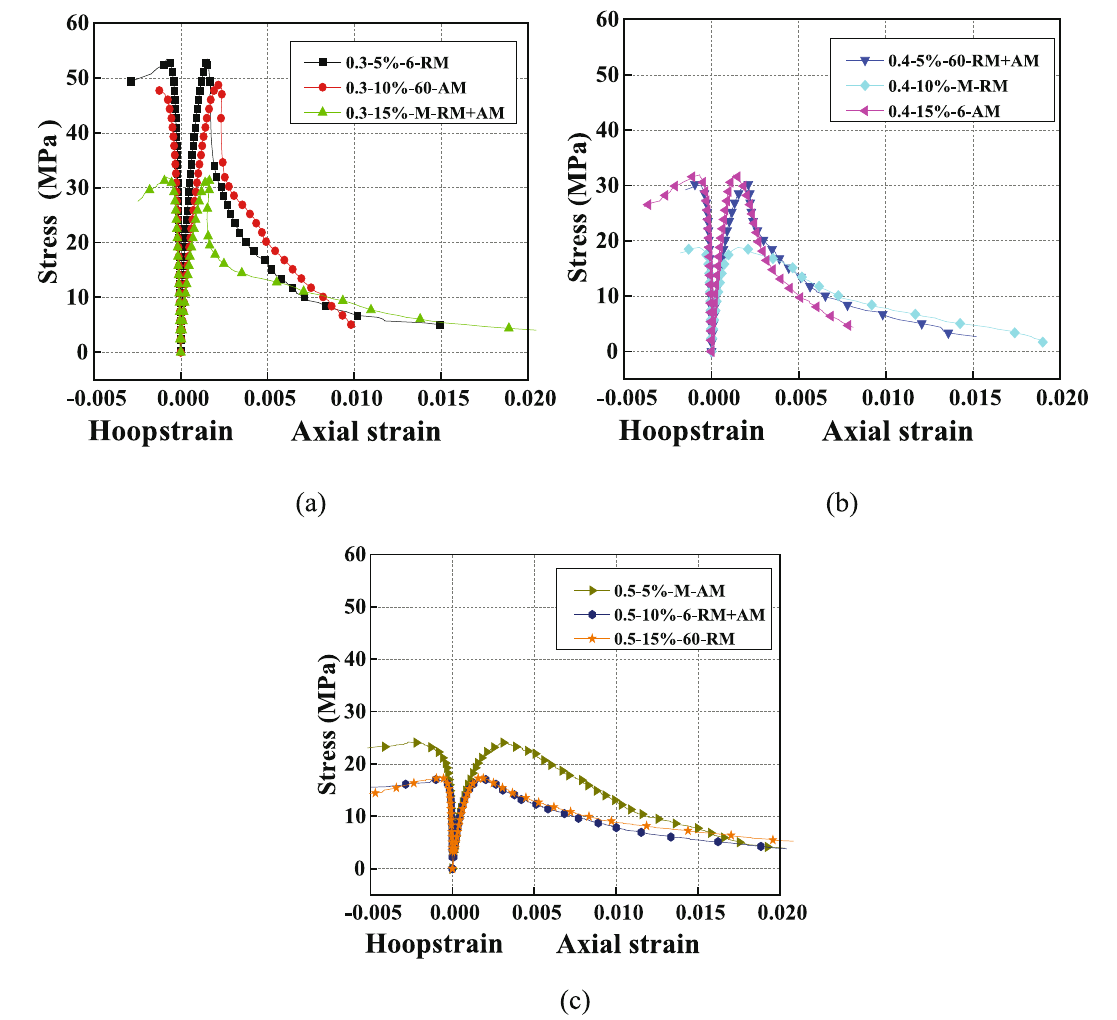
Figure 13: Stress – strain curve of RRAC with di ff erent w/c ratios of: ( a ) 0.3, ( b ) 0.4, and ( c )